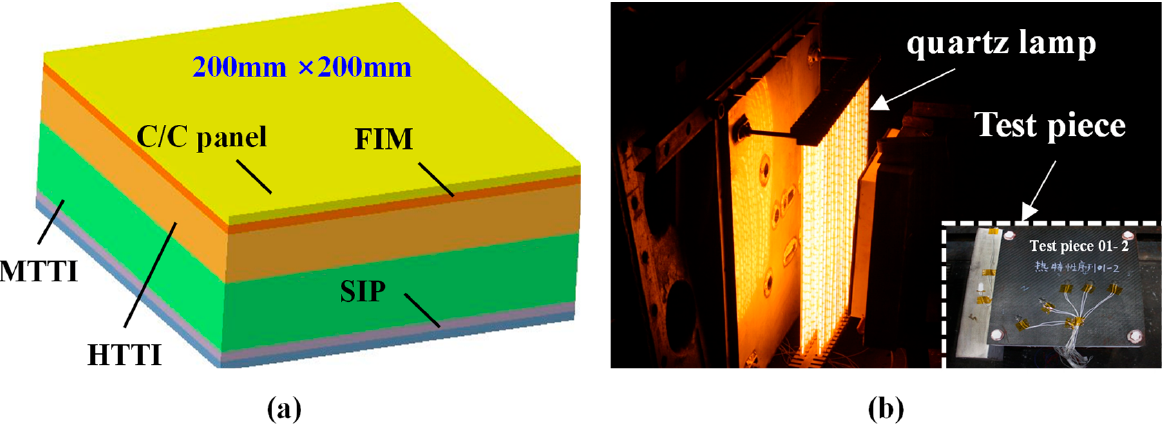
Figure 10. Setup of the thermal insulation performance test. ( a ) The thermal protection tile; ( b ) The experiment setup.